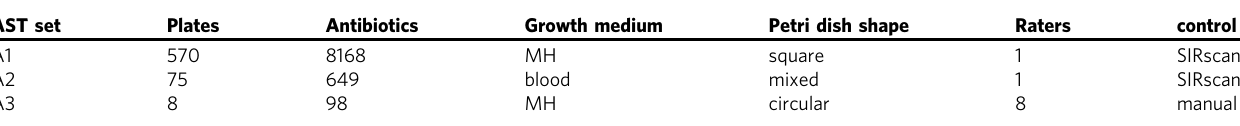
Table 1 Description of the AST sets used for the performance evaluation of the automatic reading. For each dataset, the columns indicate: the number of single Petri dishes in the dataset, the corresponding total number of antibiotic disks, the type of growth medium, the shape of the plates, the number of independent raters measuring the diameters, the reference used as control